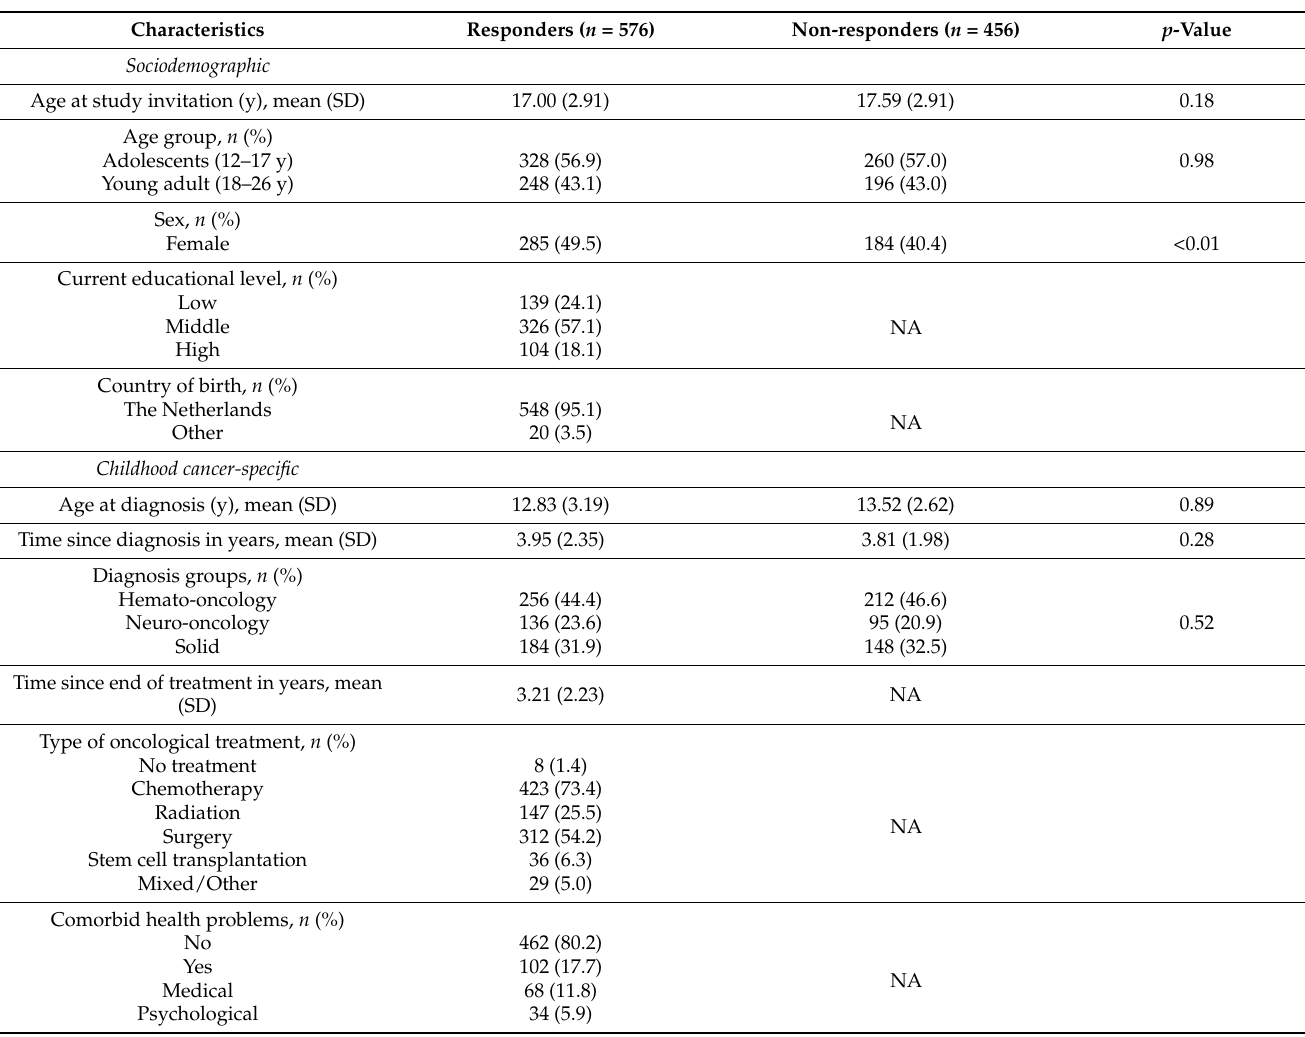
Table 1. Sample characteristics.